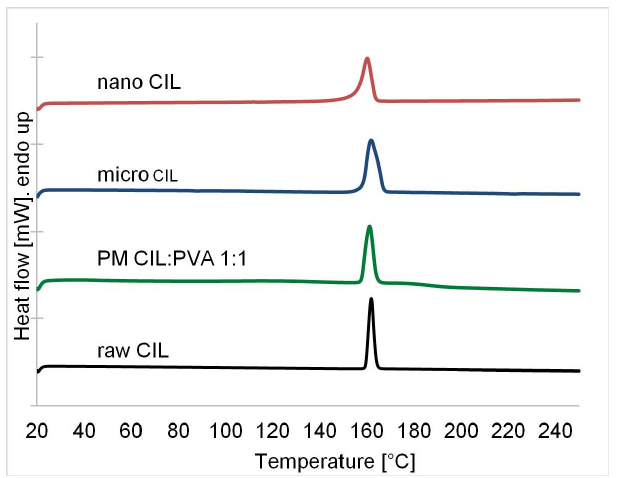
Figure 13. Differential scanning calorimetry (DSC) curves of unprocessed cilostazol, its physical mixture (PM) with PVA, and micro- and nanocrystals.